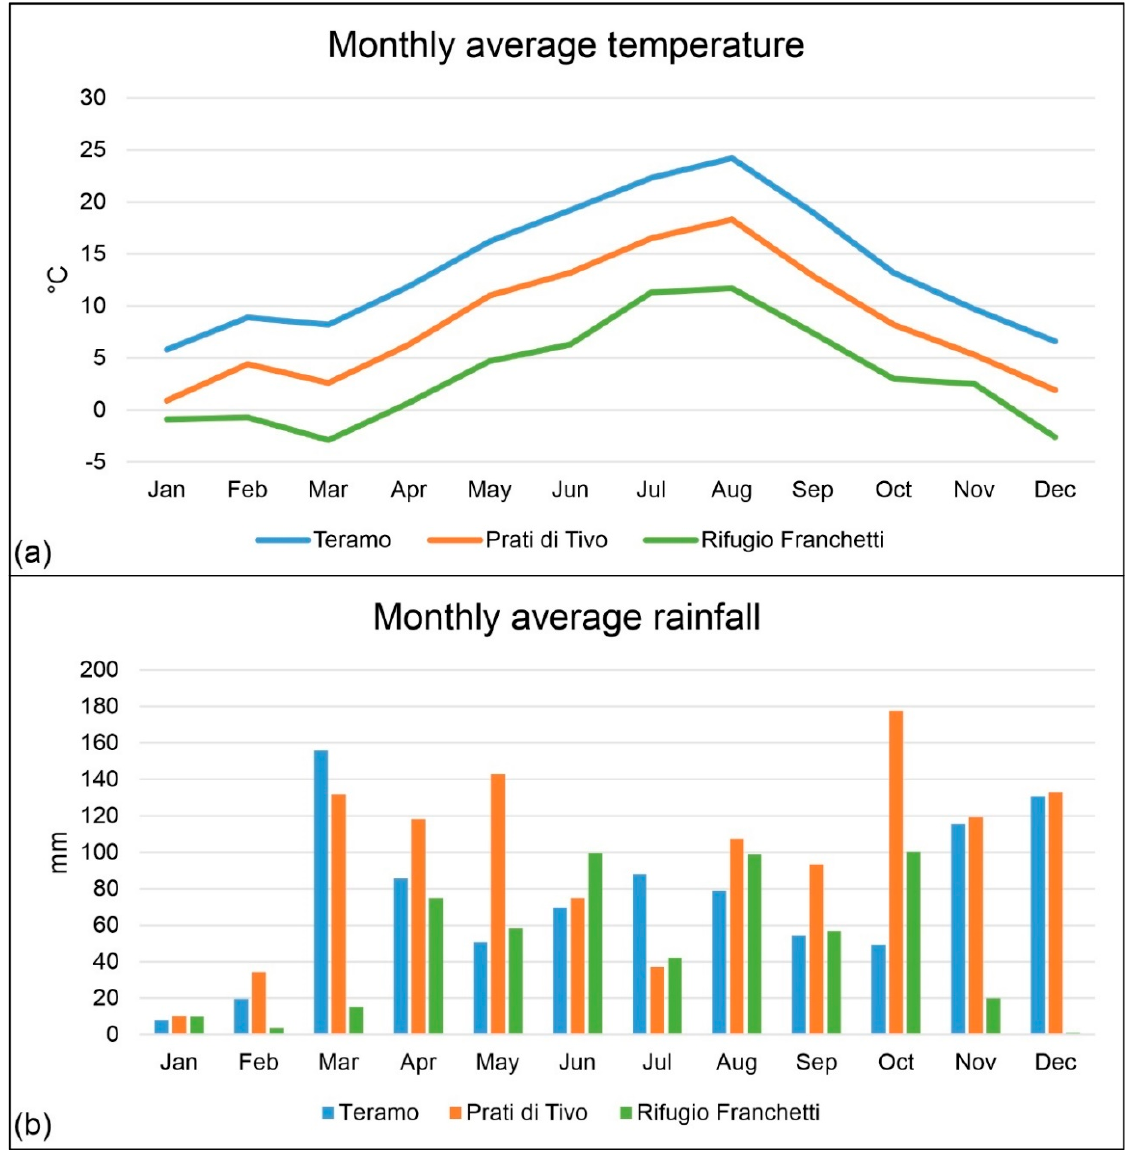
Figure 7. Monthly average temperature ( a ) and monthly average rainfall ( b ) trends for the year 2020.